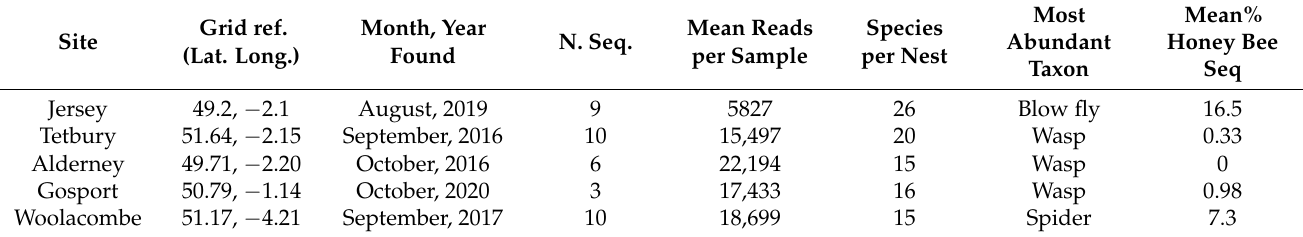
Table 1. List of the nests used with the approximate nest location (to preserve the anonymity of landowners), month the nest was captured and destroyed, the number of samples that were successfully sequenced (N. Seq), the average number of reads per larvae, the number of different species DNA found among the samples analysed, and the most abundant taxon found as a percentage of total reads per nest and the percentage of total reads per nest represented by Apis mellfera (honey